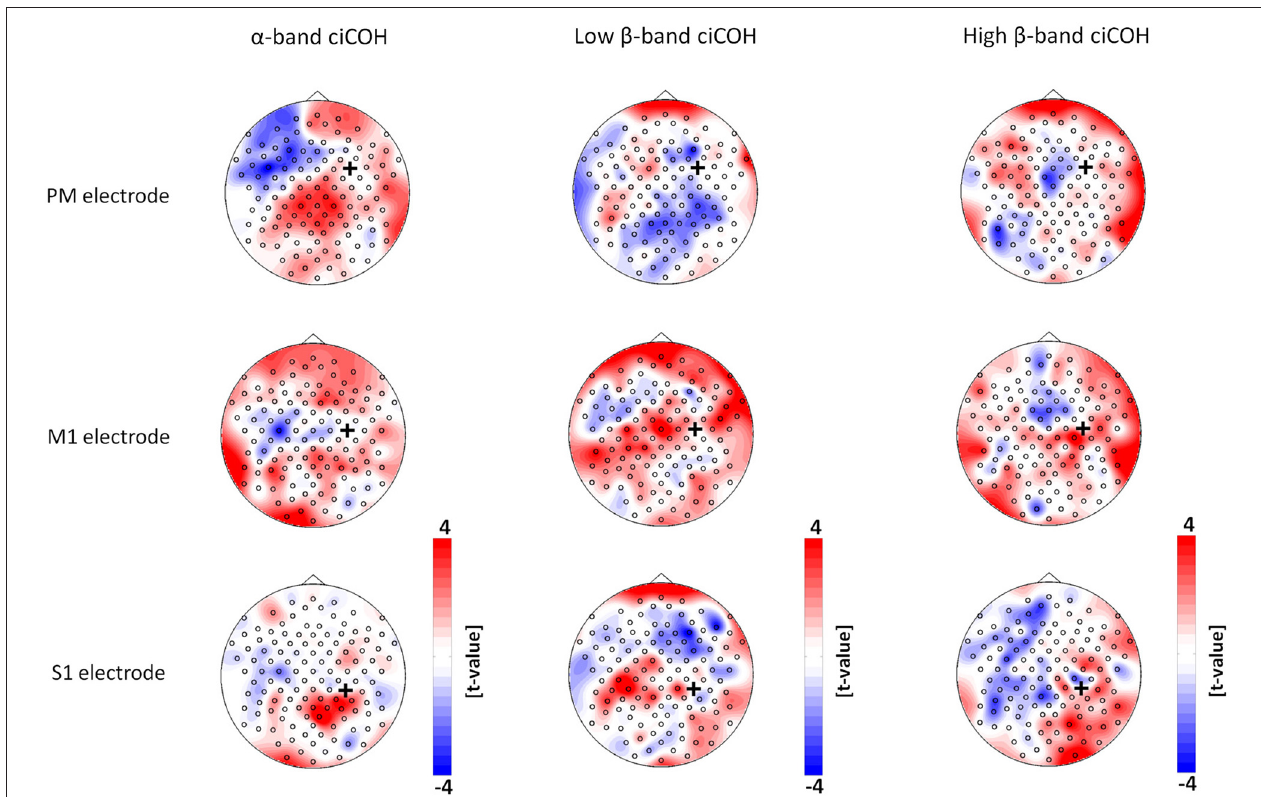
of the right hemisphere. The first column shows the results for the α -band, the second column for the low β -band, while the third column shows the results for the high β -band. Note that no significant differences were